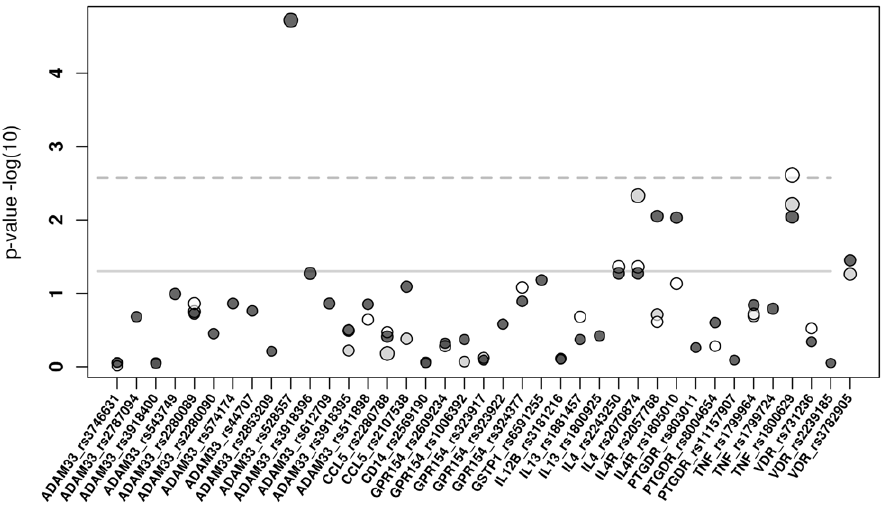
Figure 3. Comparison of effect sizes and p-values derived from regenotyped SNPs with data based on imputation. Log transferred p- values are shown on the y-axis. Each individual SNP effect is depicted as a circle where the diameter of the circle reflects the respective odds ratios. The dark grey circles represent the regenotyping the light grey circles stand for the imputation based on HapMap2 and the transparent show the imputation data based on HapMap3. Significance level are marked as solid (p=0.05) and dashed grey lines (p=0.0035).